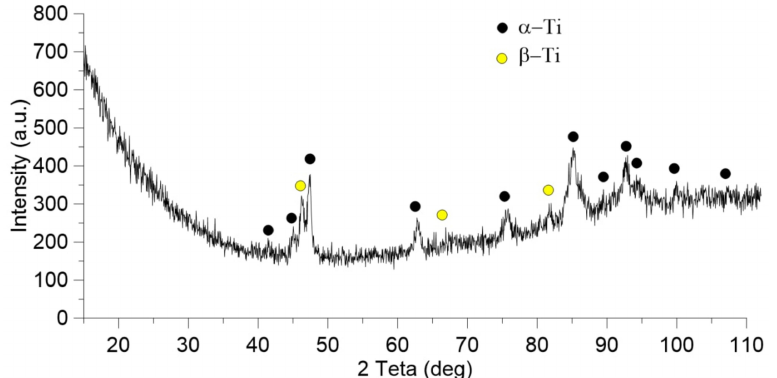
Figure 14. The X-ray diffraction pattern of the weld fracture surface after mechanical testing on the sample 2.